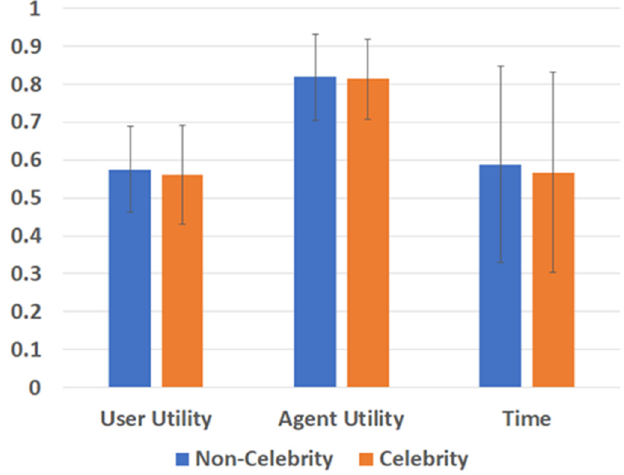
Figure 7. Mean with Error Bars of Negotiation Performance Metrics.